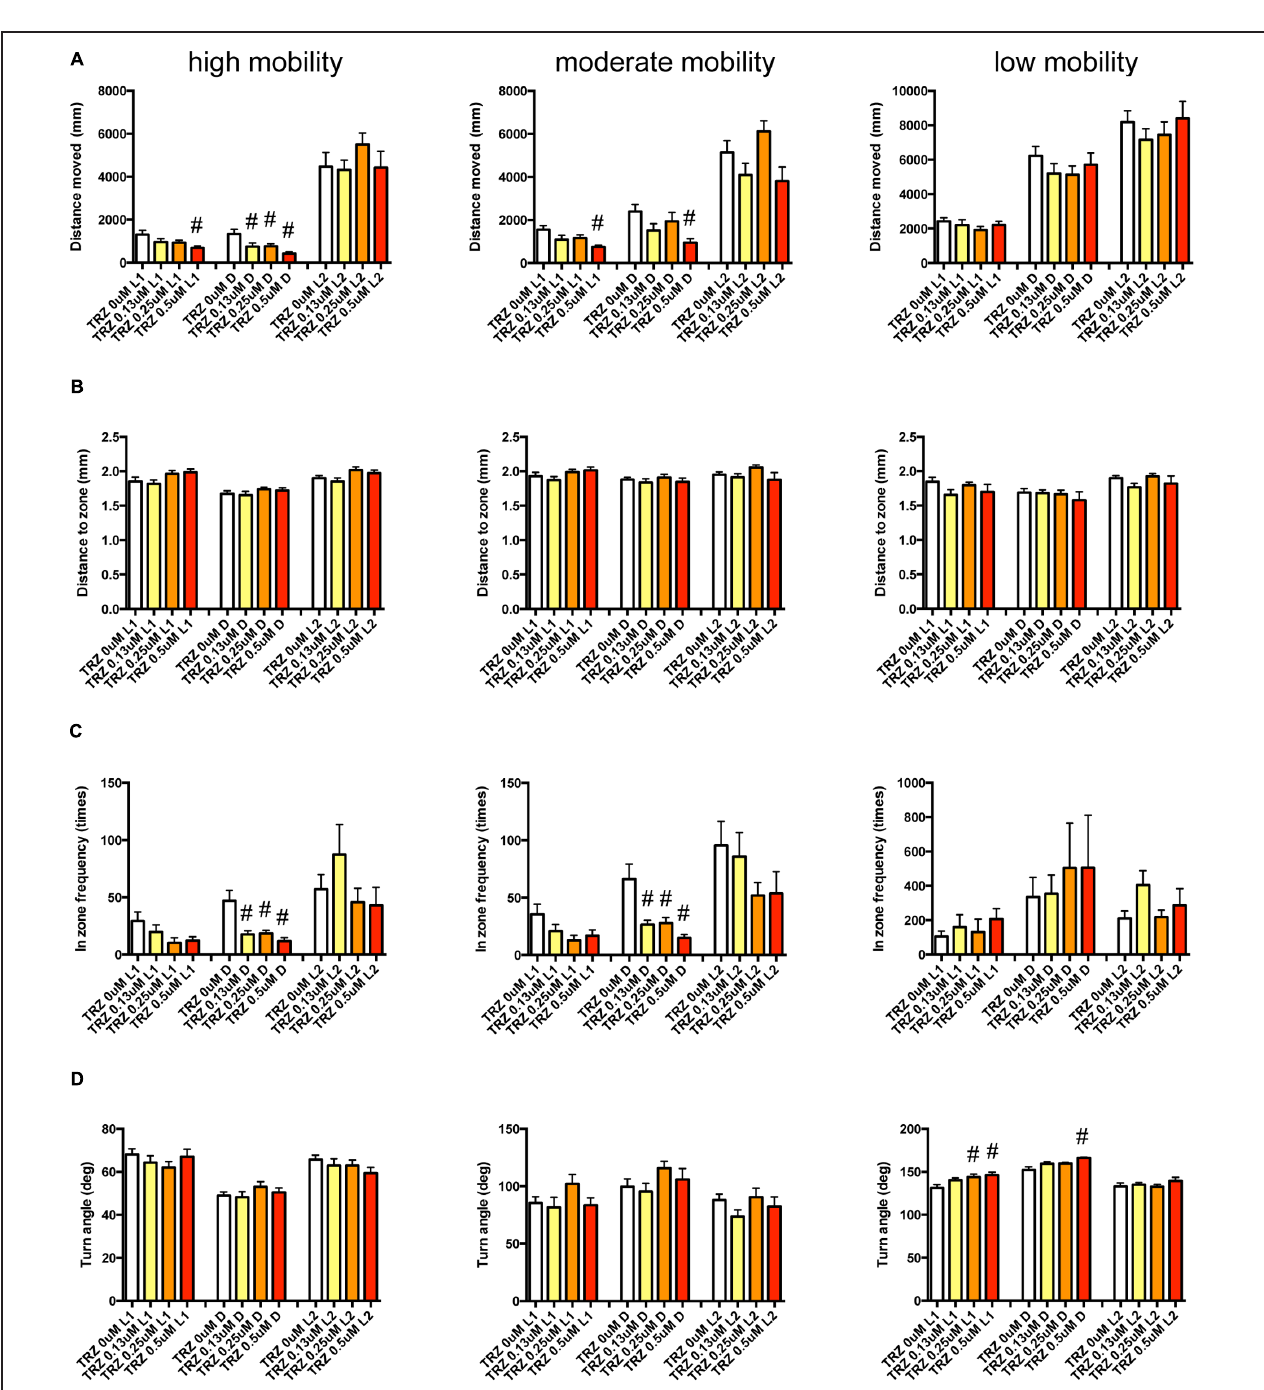
FIGURE 8 | Behavioral profiling of zebrafish treated with triazolam. The behavior of zebrafish treated with triazolam from 9 to 10 dpf were classified into three groups based on their mobility. Distance moved (A) , distance to zone (B) , in zone frequency (C) , and turn angle (D) at L1, D, and L2 periods are shown for each mobility. The data were represented as means with the standard error of mean. # p < 0.05 vs. 0 μ